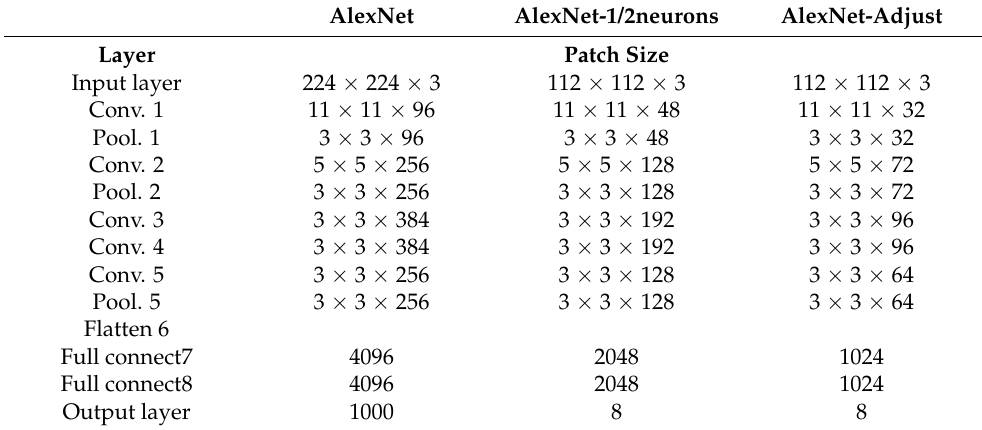
Table 2. Adjusted AlexNet